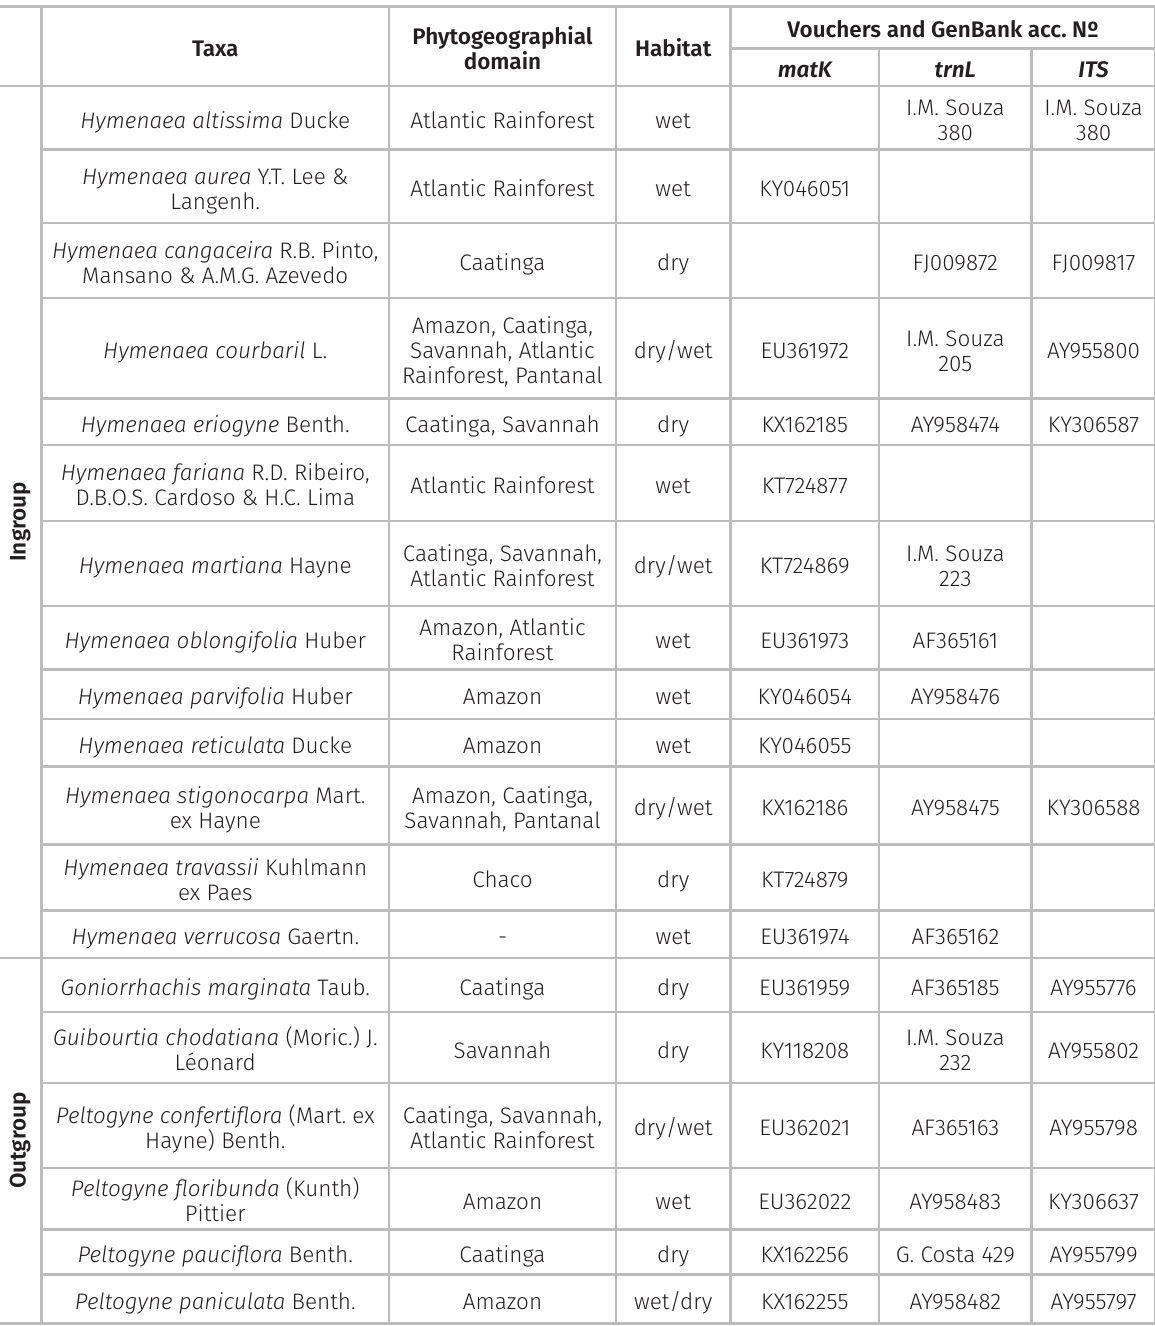
Table I. List of taxa ( Hymenaea , Guibourtia and Peltogyne ) used in the phylogenetic inference, markers, vouchers and GenBank